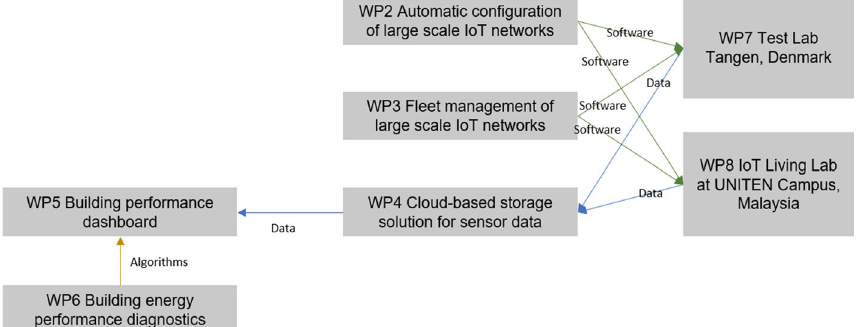
Fig. 1 Overview of work packages and their